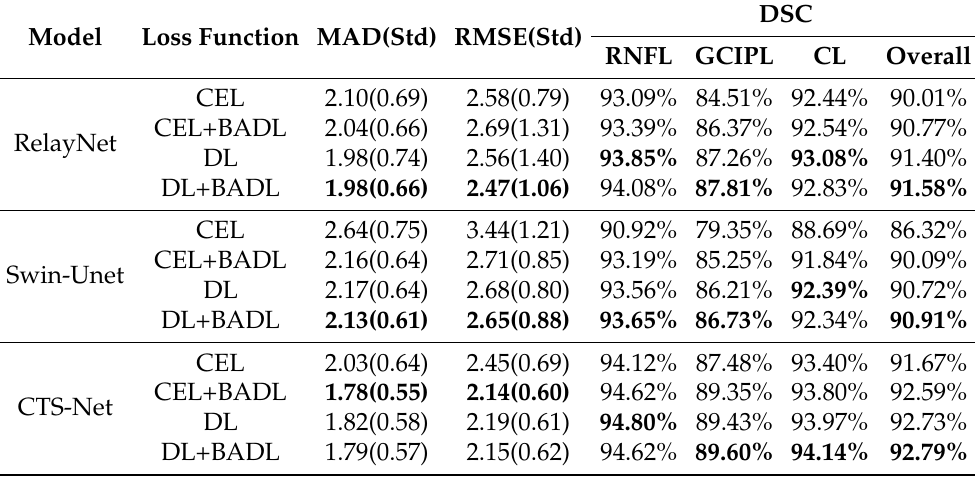
Table 4. The results of the model using different combinations of loss functions.